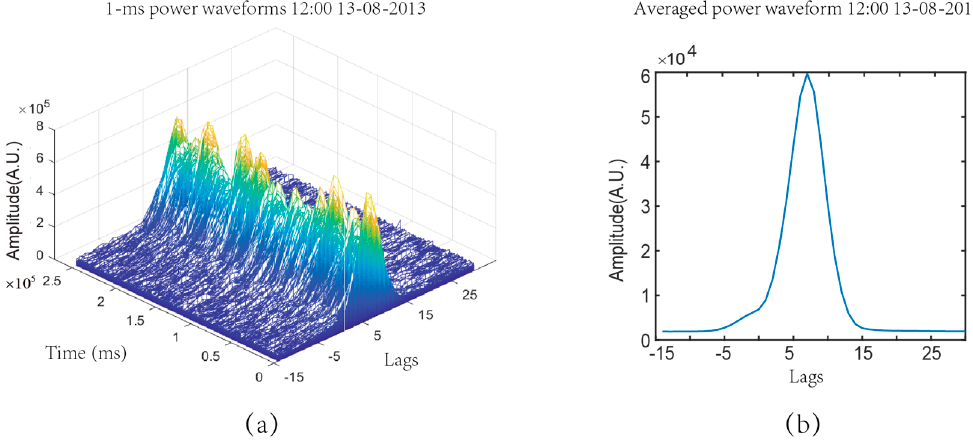
Figure 5. Power waveforms at 12:00 on August 13, 2013. ( a ) 1 ms power waveforms; ( b ) Averaged power waveform (coherent integration time = 50 ms, incoherent integration: N = 5000).